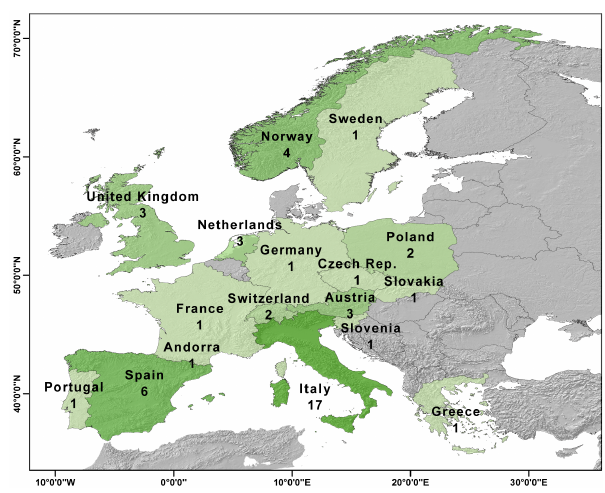
Fig. 1. Countries of origin of the answers to the Figure 1. Countries of origin of the answers to the questionnaire . 3